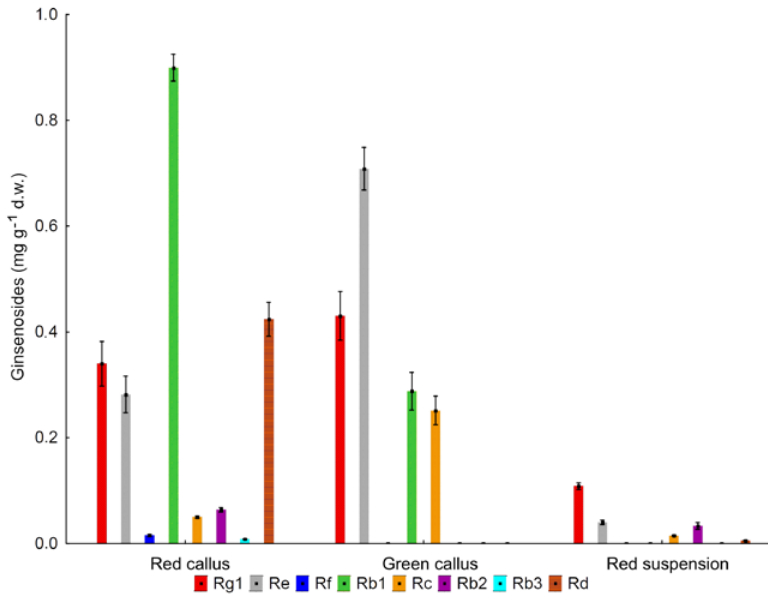
Fig. 4 The content of individual ginsenosides in RCL, GCL, and suspension cultures of P. quinquefolium . Each value represents the mean of three replicates ± SE